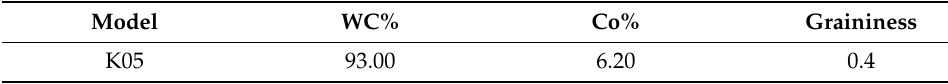
Table 1. Cemented carbide specimen composition.